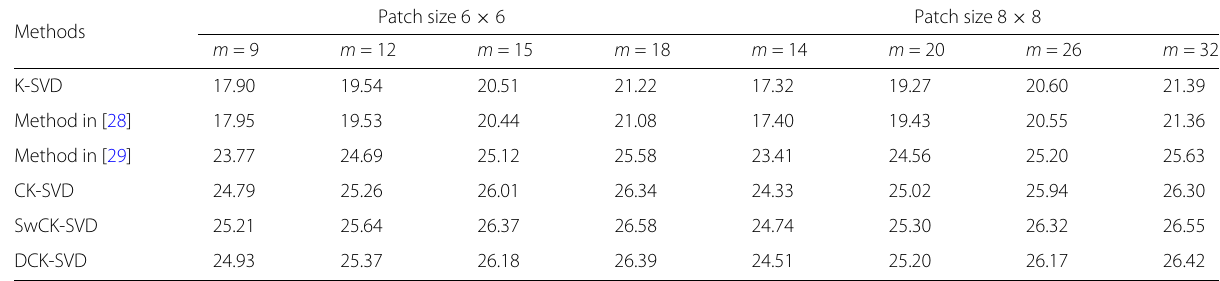
Table 3 Comparison of PSNR (dB) of reconstructed image “Horse” with different number of measurements Methods